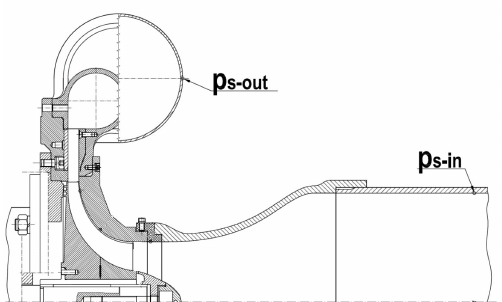
Figure 3. Cross-section of the blower with indicated positions of pressure gauges.